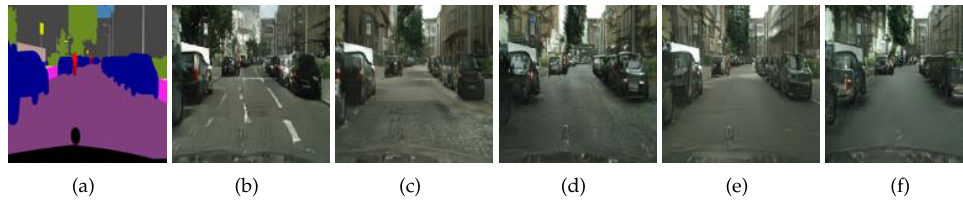
Figure 6. ( a ) Input, ( b ) Output (Baseline), ( c ) Output (P50%), ( d ) Output (P75%), ( e ) Output (P50%, W8A8), ( f ) Output (P75%, W8A8). We provide examples of images generated from CycleGAN given the same input (left). Here, P50% and P75% denote 50% and 75% channel pruning, respectively.